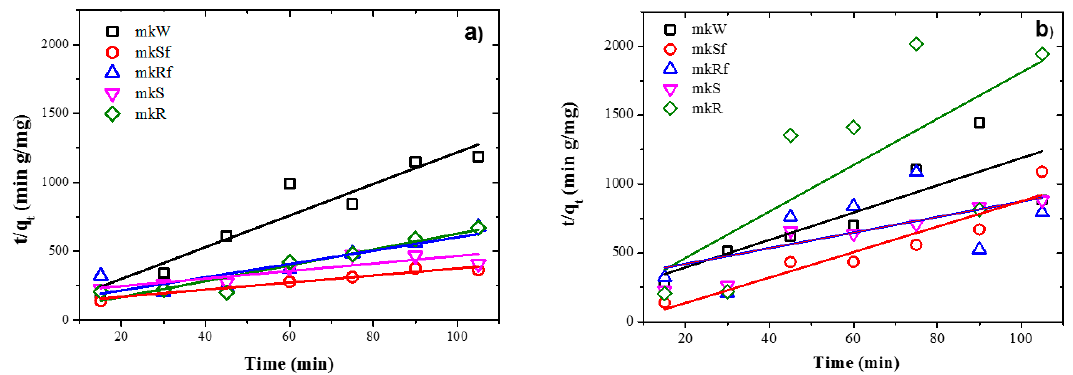
Figure 8. Plots of the pseudo-second order kinetics of MB adsorption on metakaolin-based alkaline cements with addition of ZnO nanoparticles in; ( a ) under UV irradiation and ( b ) dark conditions.